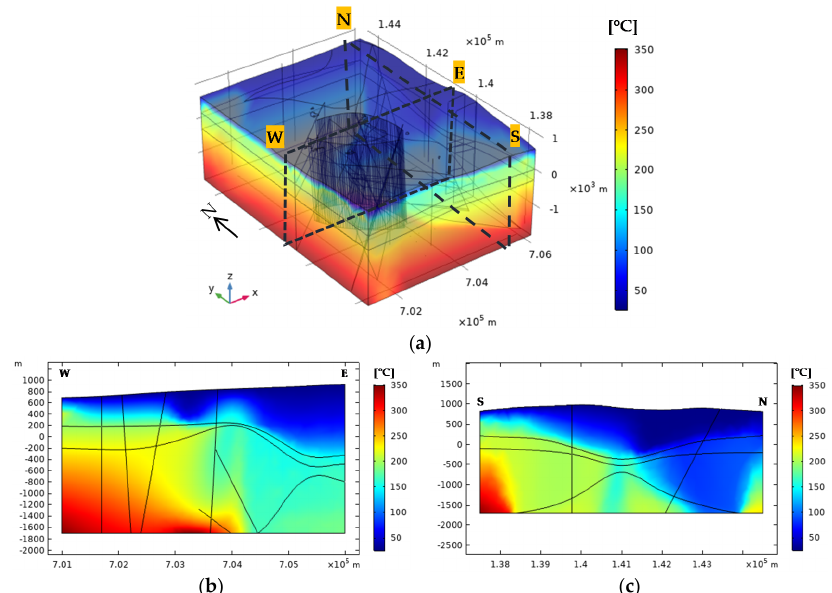
Figure 15. Geothermal field temperature under natural state condition: ( a ) 3D geometry; ( b ) cut plane in y = 141,000 m, ( c ) cut plane in x = 705,500 m.